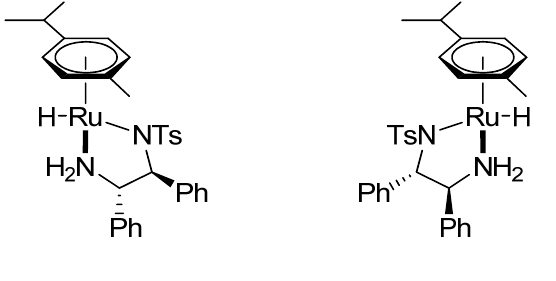
Figure 7. Two diastereomers of [RuH( η 6 - p -cymene)( S , S )-TsDPEN]. The structures differ by configuration on the Ru atom, while both feature the ( S , S )-TsDPEN